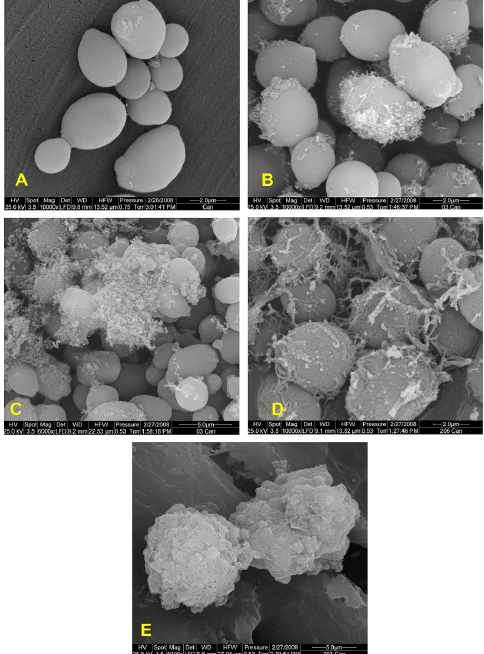
Figure 7. Scanning electron microscope image of Candida albicans cells treated with dendrimeric lipopeptides developed by Zofia Urbánczyk-Lipkowska and colleagues. ( A ) Intact cells; ( B – C ) Cells after exposure to lipopeptide 12 at 4 μ M (0.5× minimal inhibitory concentration (MIC)) and at 10 μ M (1.5× MIC); ( D – E ) Cells after exposure to lipopeptide 16 at 4 μ M (0.5× MIC) and at 64 μ M (8× MIC), respectively. From [42]. Reproduced with permission.